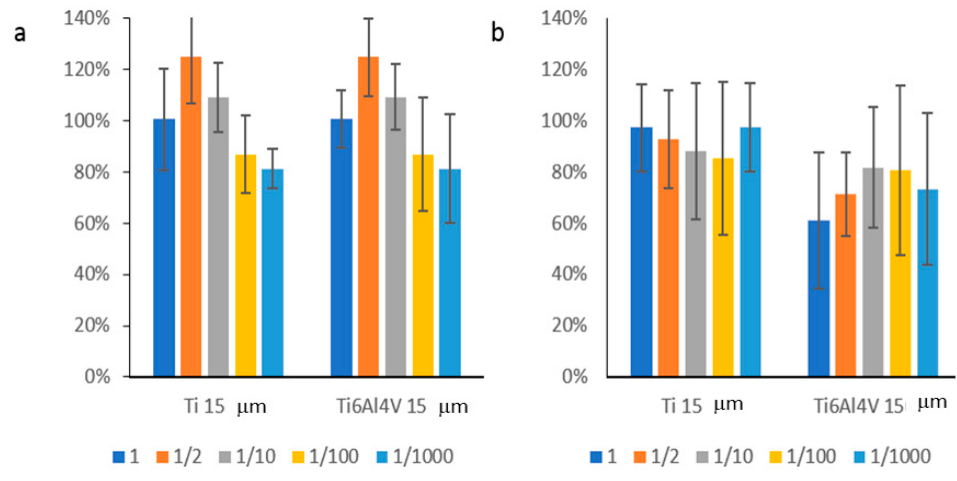
Figure 7. Cellular viability in the cytotoxicity tests: ( a ) SAOS–1 and ( b ) HFF–1. Cytotoxicity tests have shown values slightly above 80% cell survival in both cell lines tested for the Ti–15 μ m powder. However, the Ti6Al4V powder showed mean cell survival values below 80% for the HFF – 1 cell line. In view of the results, a certain tendency towards an increased cell cytotoxic effect on human fibroblasts (gingival tissue) of Ti6Al4V powder particles compared to titanium particles is confirmed. A cytotoxicity as- cells were cultured in medium containing the extracts at different concentrations: [ISO] (0.2 g/mL), and their dilutions 1:2, 1:10, 1:100 and 1:1000. According to regulations, a cell